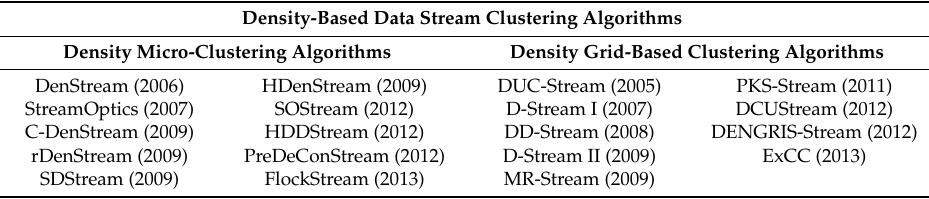
Table 1. Density-Based data stream clustering algorithms’